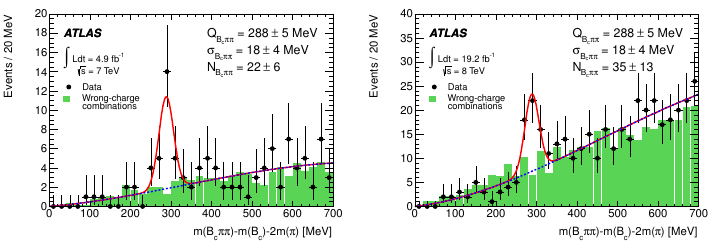
Figure 9. The Q distribution for the right-charge combinations (points with error bars) and for the same (wrong) pion charge combinations (shaded histogram) in (left) 7 TeV and (right) 8 TeV data. Figures are taken from Ref.